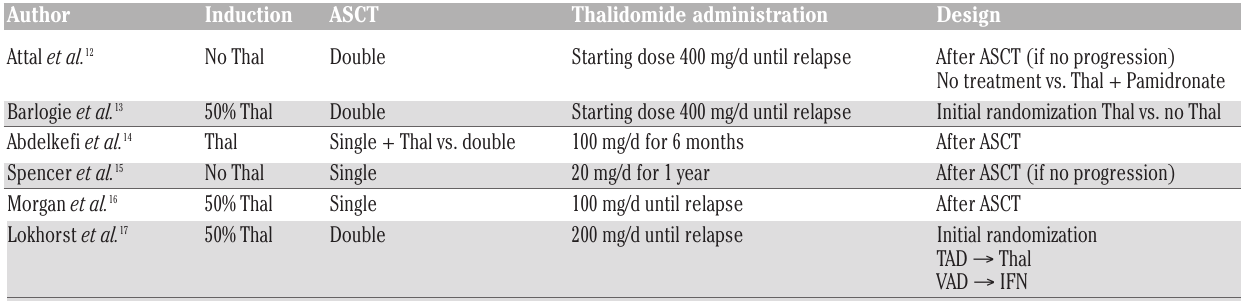
Table 1. Post-ASCT maintenance with thalidomide: randomized studies. Author